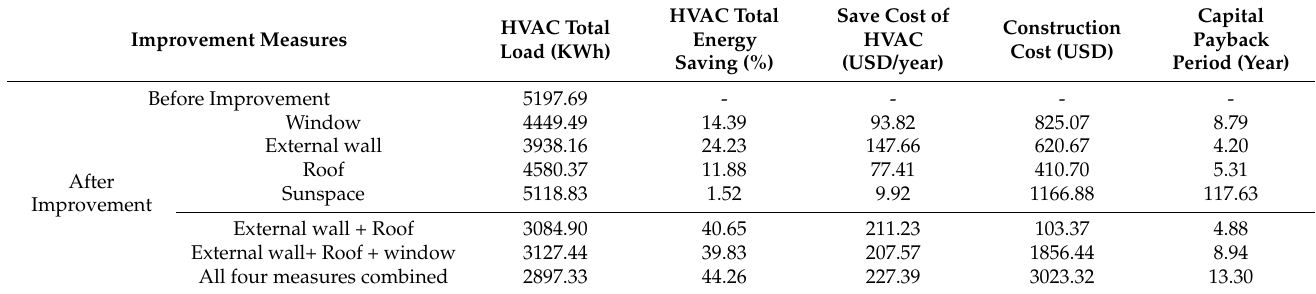
Table 5. The energy consumption analysis for the simulation before and after improvement.